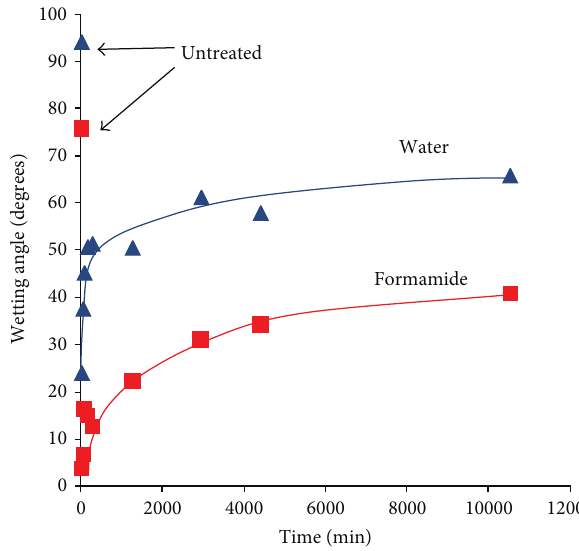
F 11: Water and formamide wetting angles of LDPE with time aer PIII treatment. Marked signs correspond to untreated LDPE surface. Most recover of contact angle occurs shortly aer PIII. However, the contact angle never comes back to